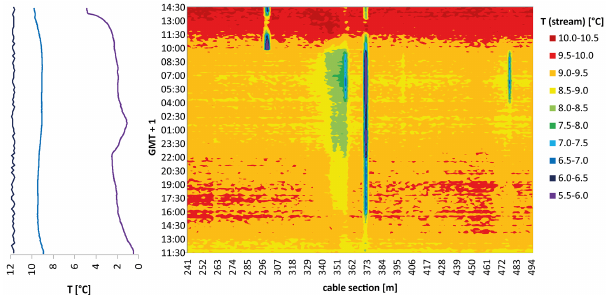
Figure 6. Air (purple), stream (light blue) and groundwater (dark blue) temperature (line diagram, left side) and surface water temper- atures (colour plot, right side) of the Chriesbach after river restora- tion, on 28–29 November 2013. The x axis of the colour plot shows the sections of the fibre-optic cable in metres; the colours repre- sent the surface water temperatures in ◦ C. Each coloured line on the x axis, from cable section 241 to 493m, represents one mea- surement. The y axis states the time of the